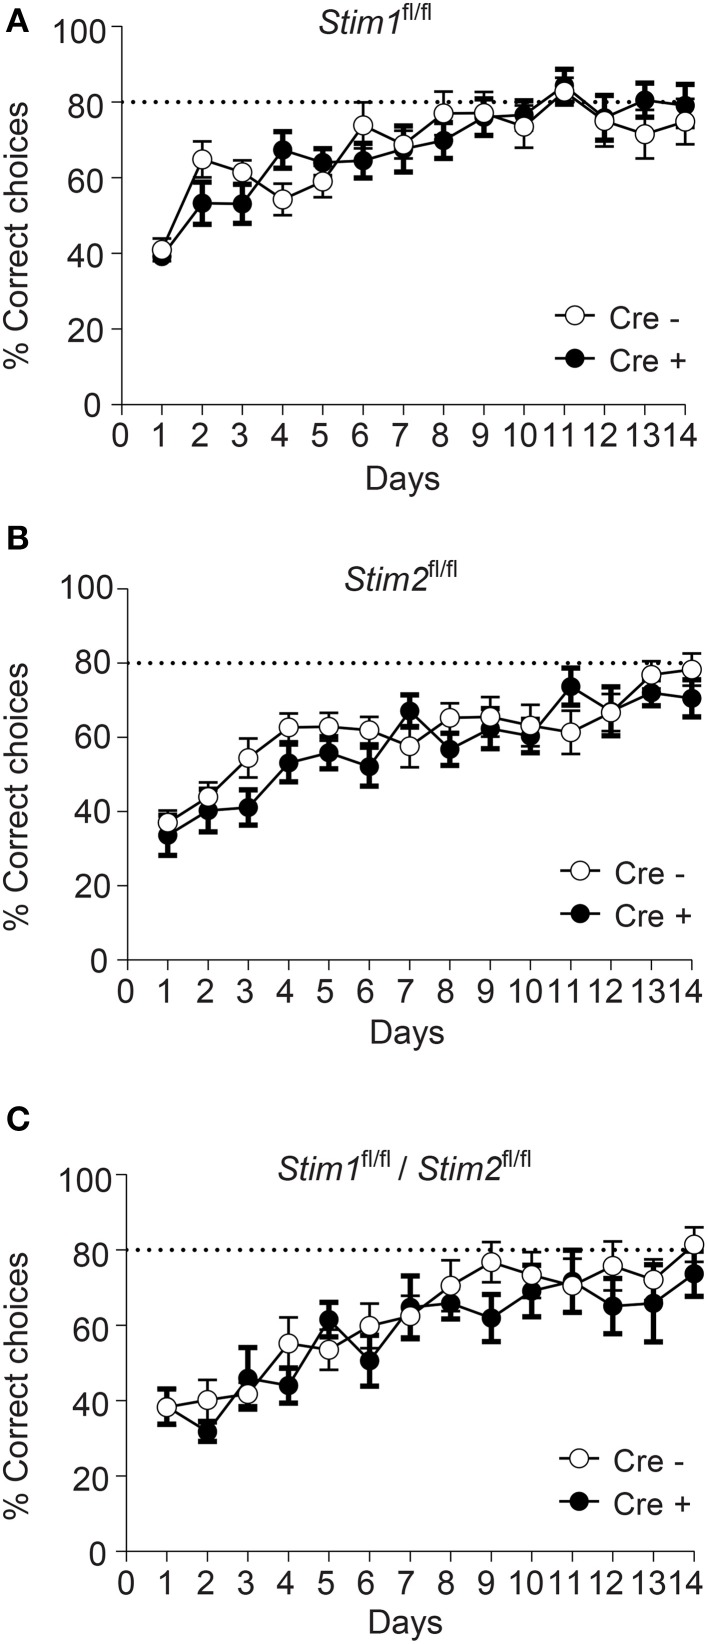
Unaltered spatial working memory in
Stim
cKO mutant mice. (A–C) Percentage of correct choices in the radial arm maze plotted for each training day as the mean ± SEM. Performance reaches a plateau at 80% correct choices (dashed line) around the 10th day of training. (A)
Stim1fl/fl;Cre+ (n = 12) and Cre− (n = 12) mice. (B)
Stim2fl/fl;Cre+(n = 12) and Cre− (n = 12) mice. (C)
Stim1fl/fl/Stim2fl/fl;Cre+ (n = 7) and Cre− (n = 10) mice. Two Way ANOVA showed a learning effect (p < 0.001 with “days” as within factor) but no genotype effect (p > 0.05, “genotype” as in between factor).